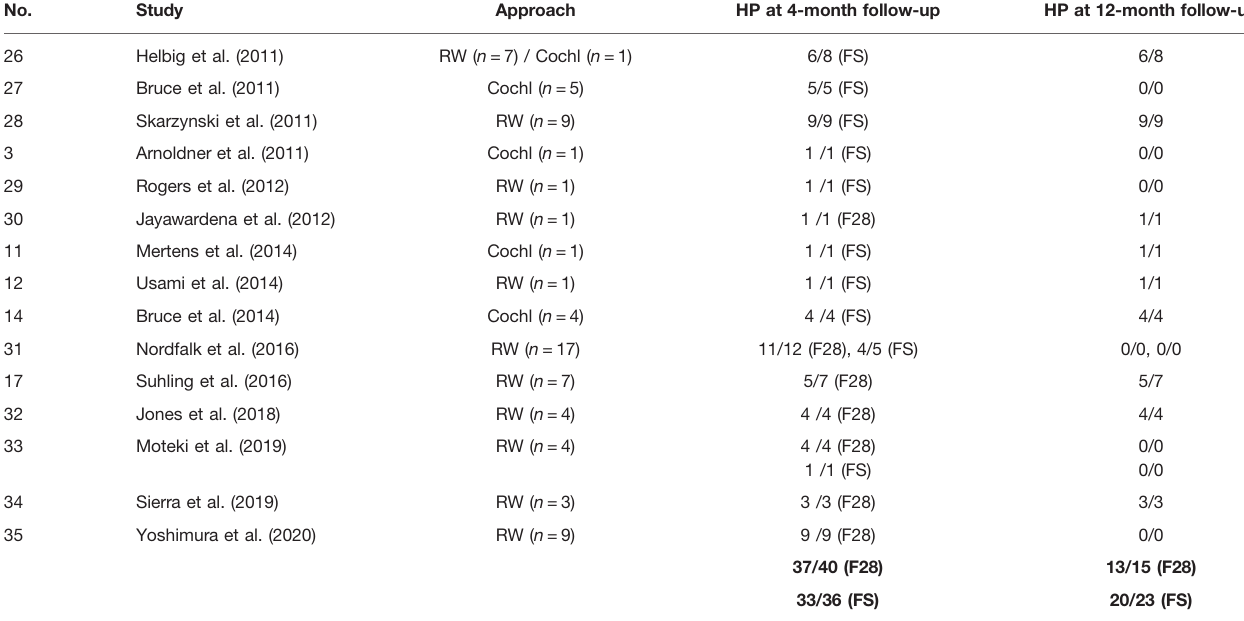
TABLE 3 | Studies that reported on the number of HP patients implanted with FLEX28 (F28) and FLEXSOFT (FS) electrodes No.